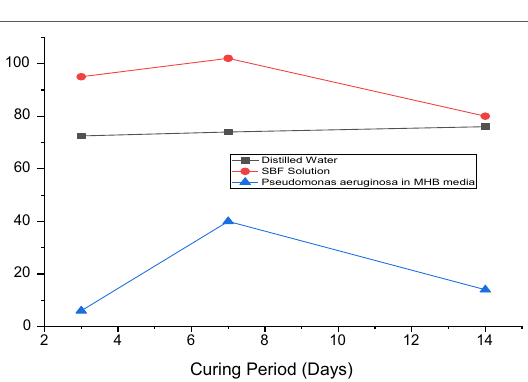
Fig. 5 Calcium ion concentration of distilled water (DW), simulated body fluid (SBF) and bacterial solution (MHB media) at different immersing periods